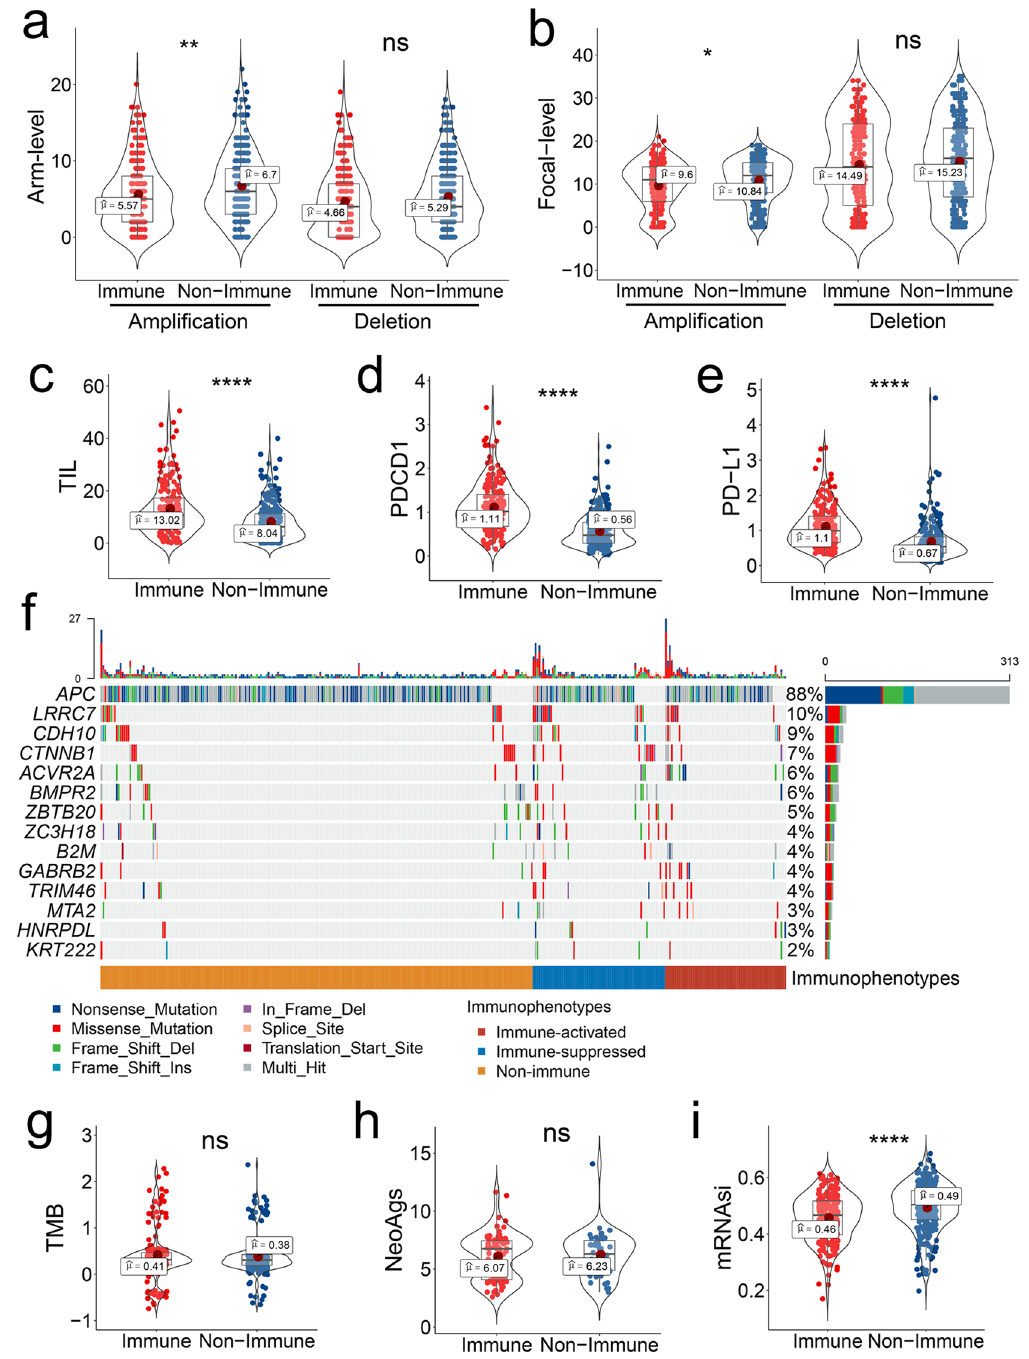
Figure 6. Correlation between immunophenotype and genetic characterization. ( a , b ) Copy number amplification and deletion at the arm and focal levels between the immune and non-immune classes. ( c ) Tumor- infiltrating lymphocyte count between the immune and non-immune classes. ( d , e ) PD-1/PD-L1 expression between the immune and non-immune classes. ( f ) Differentially mutated genes among the three immune subgroups. ( g ) Tumor mutant burden between the immune and non-immune classes. ( h ) Neoantigen content between the immune and non-immune classes. ( i ) Stemness difference represented by the mRNAsi signature between the immune and non-immune classes. Comparisons between groups were conducted using the Student’s t -test, whereas comparisons among three groups were conducted using the Kruskal–Wallis test, t -test, Student’s t -test; K–W test, Kruskal–Wallis